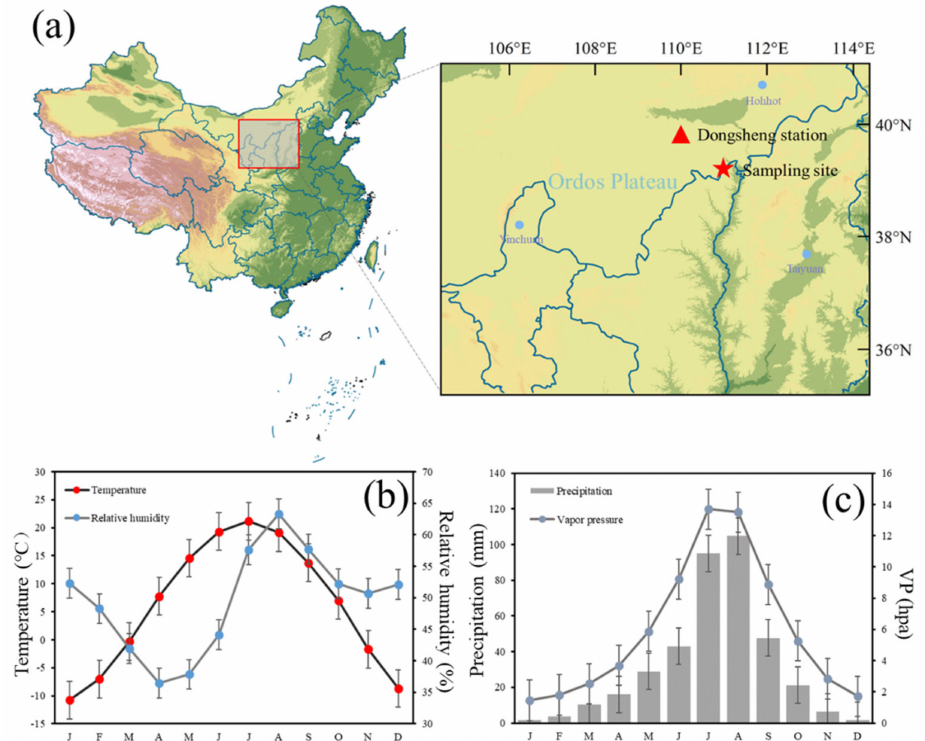
Figure 1. ( a ) Location of the study site and the nearest meteorological station (Dongsheng station). ( b ) Monthly distributions of temperature and relative humidity and ( c ) precipitation and VP at Dongsheng meteorological station from 1957 to